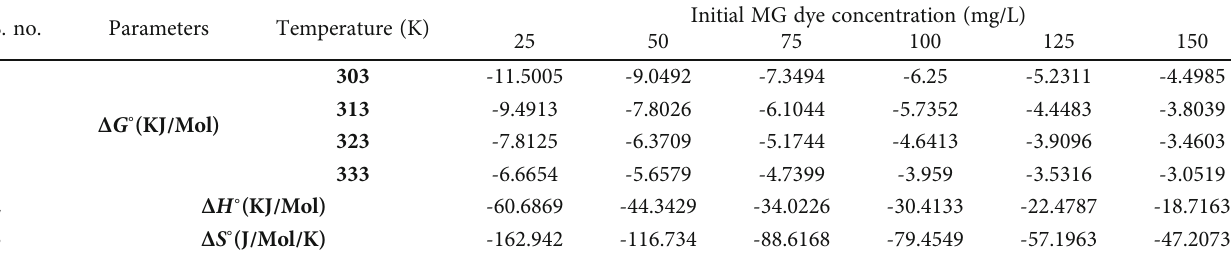
Table 4: Thermodynamic parameters for the adsorption of MG dye onto UAESP. S.